Question: Which visualization type does this figure use?
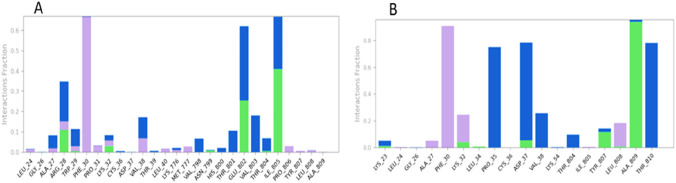
Answer: histogram